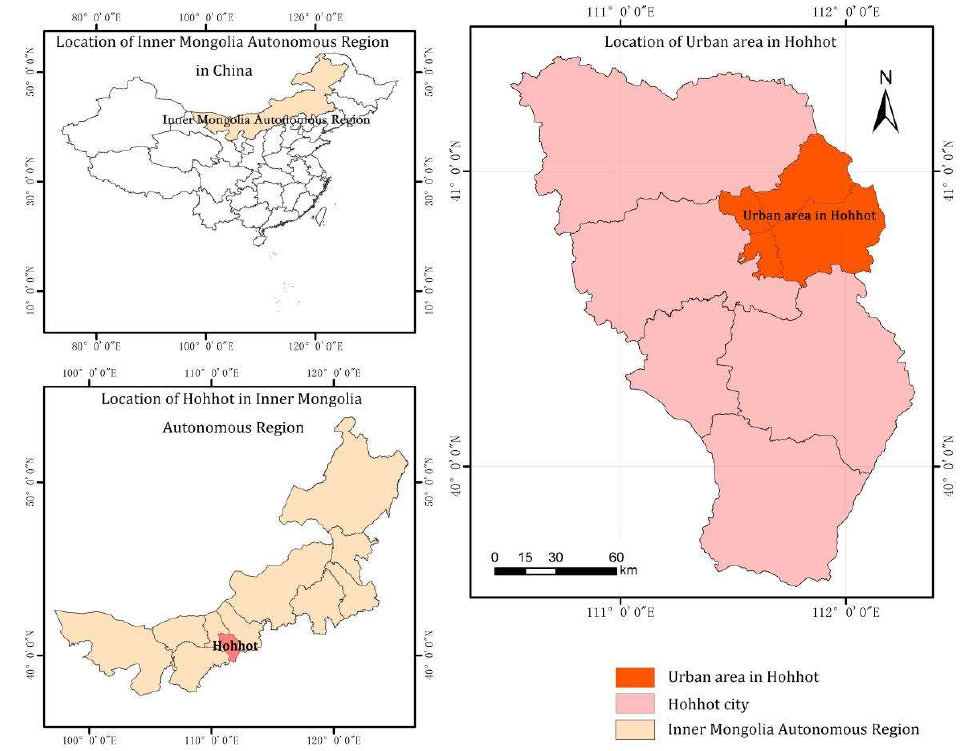
Figure 1. Location map of Hohhot City.